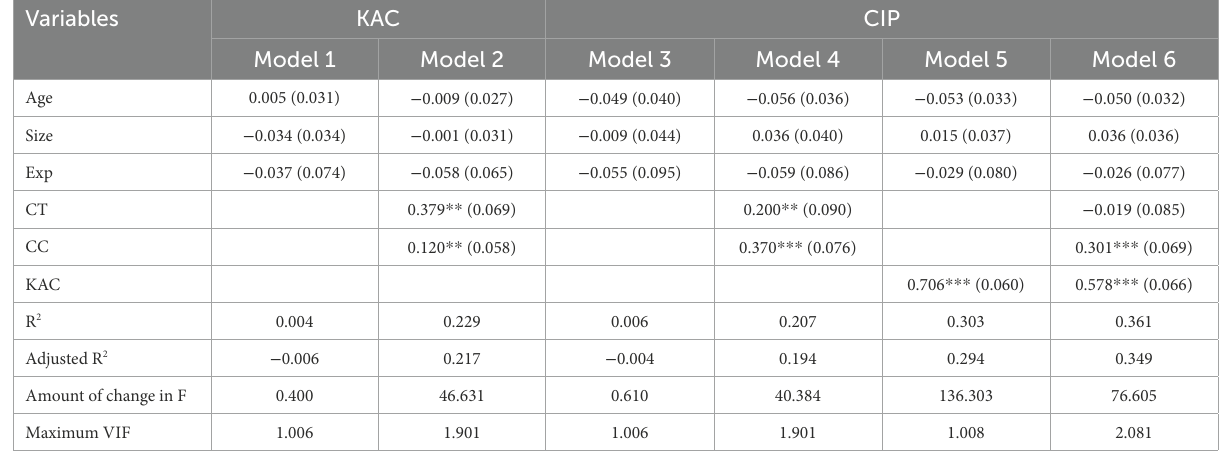
TABLE 5 Results of regression analysis.